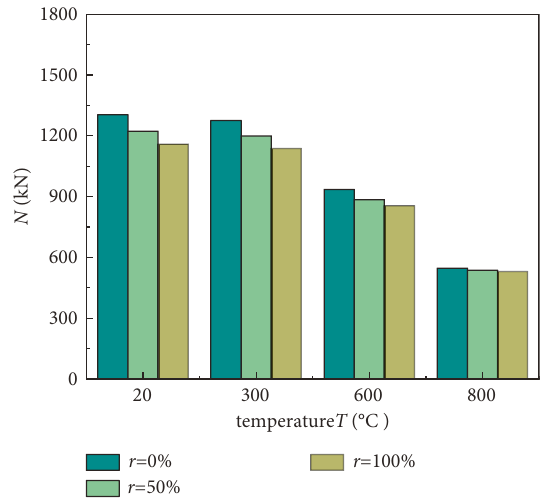
Figure 8: Influence of substitution rate on ultimate bearing capacity.